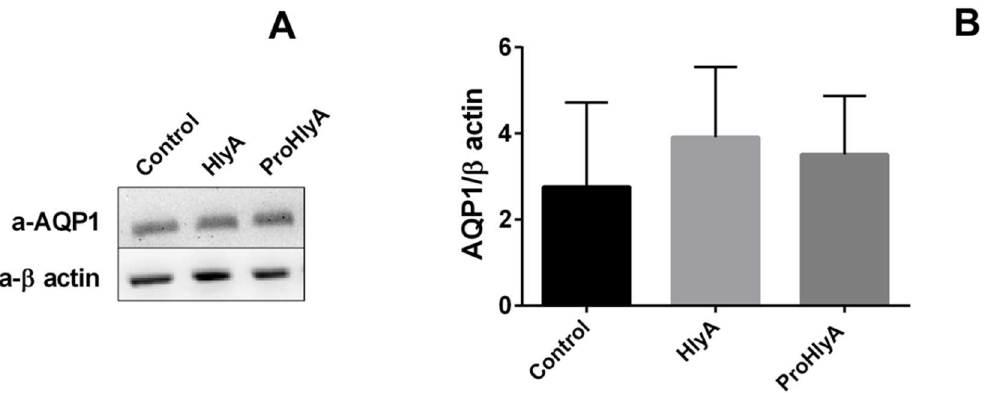
Figure 6. Western blot analysis of AQP1 in RBCs membranes. ( A ) RBCs suspensions at 10% hematocrit were treated with vehicle (Control), HlyA 100 ng/mL and ProHlyA 1 µ g/mL at 37 ◦ C for 10 min. The first row corresponds to the AQP1 band revealed with anti-AQP1 antibody. The second row corresponds to the anti- β actin antibody. ( B ) Densitometric analysis of the bands in A, expressed as the ratio between optical density of AQP1 and β -actin bands (N = 3). The fact that in HlyA-treated cells the relative decrease of P f is similar in RBCs and AQP1null RBCs, suggests that the toxin may affect other water transport mechanisms in ad- dition to AQP1.